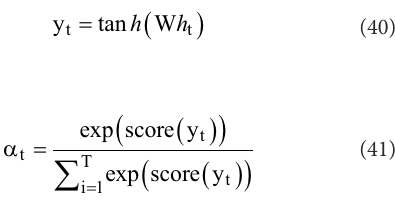
FIGURE 9 The structure diagram of LSTM-CNN